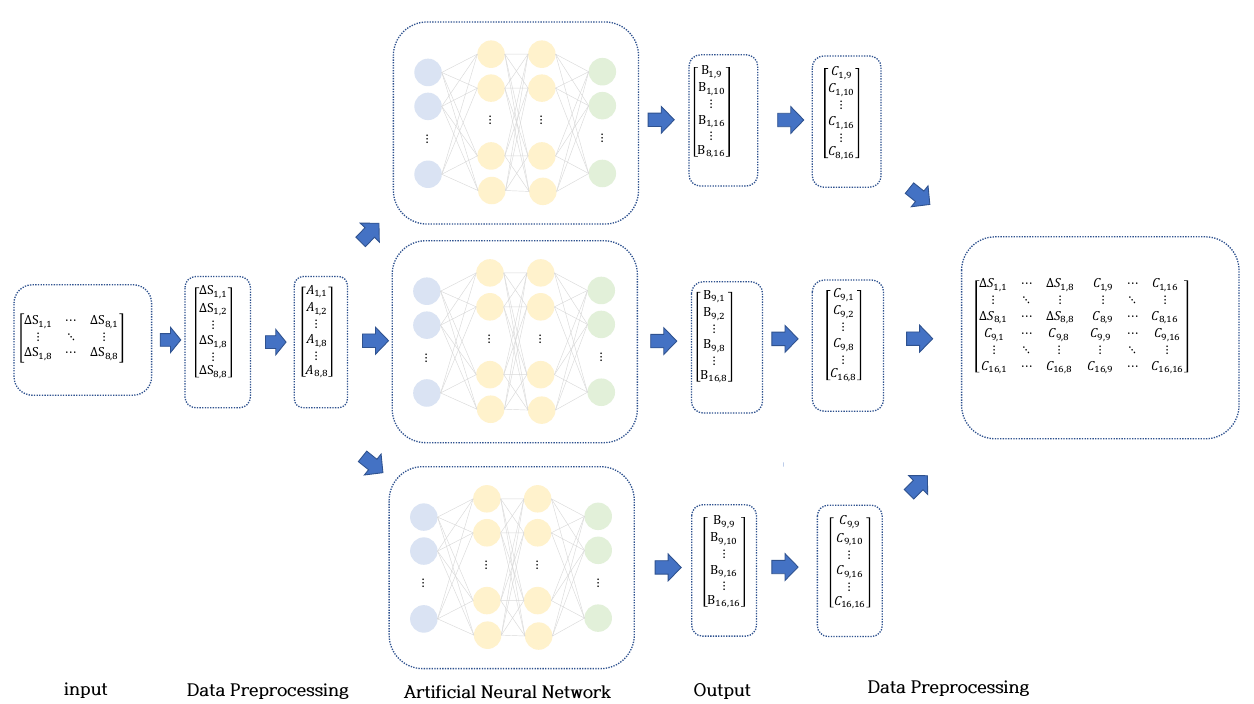
Figure 3. Schematic diagram of an artificial neural